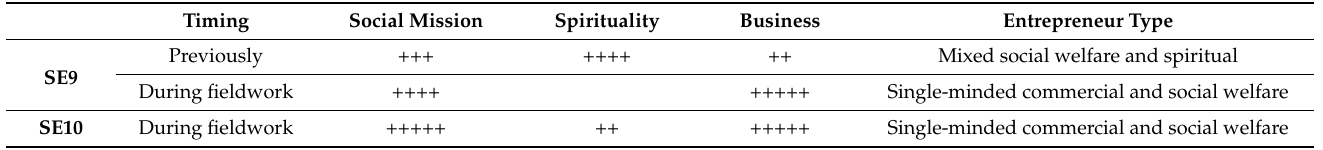
Table 5. Emphasis on institutional logics (single-minded commercial and social welfare